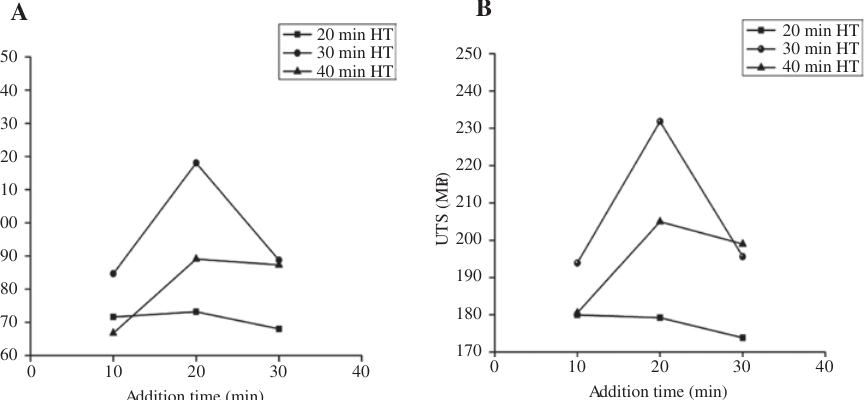
Figure 12: (A) Variations of yield stress (YS) with respect to constant AT (B) Variation of ultimate tensile strength (UTS) with respect to constant